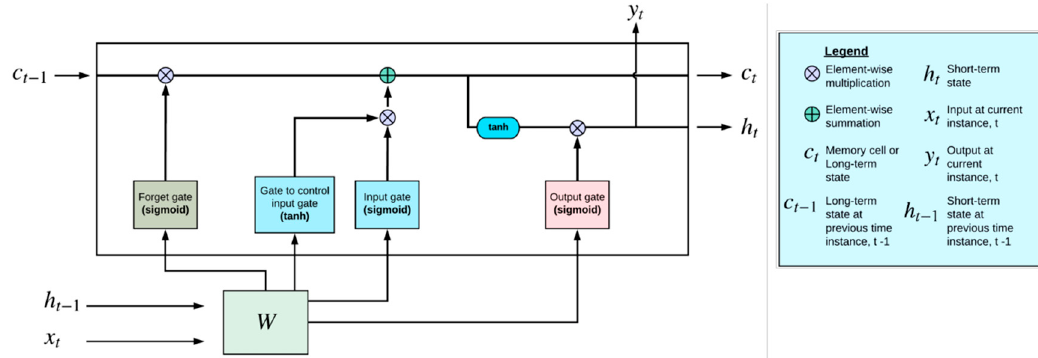
Figure 8. Diagram of a typical LSTM cell [38] (when data are received, input gate controls what information is stored in the long-term state, forget gate determines how long the stored information is preserved across the time instances, and lastly, the output gate controls the requested information at a particular time